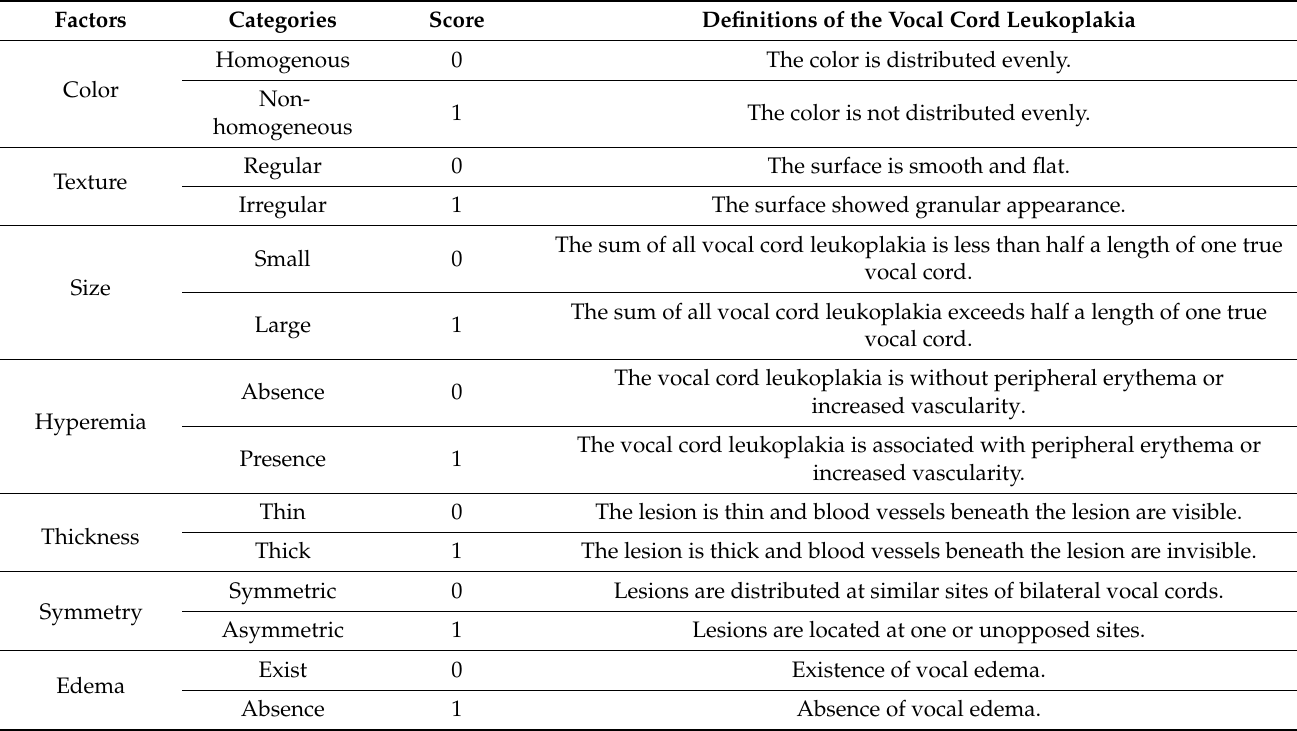
Table 4. Clinical scoring of leukoplakia according to Young et al. (2014)